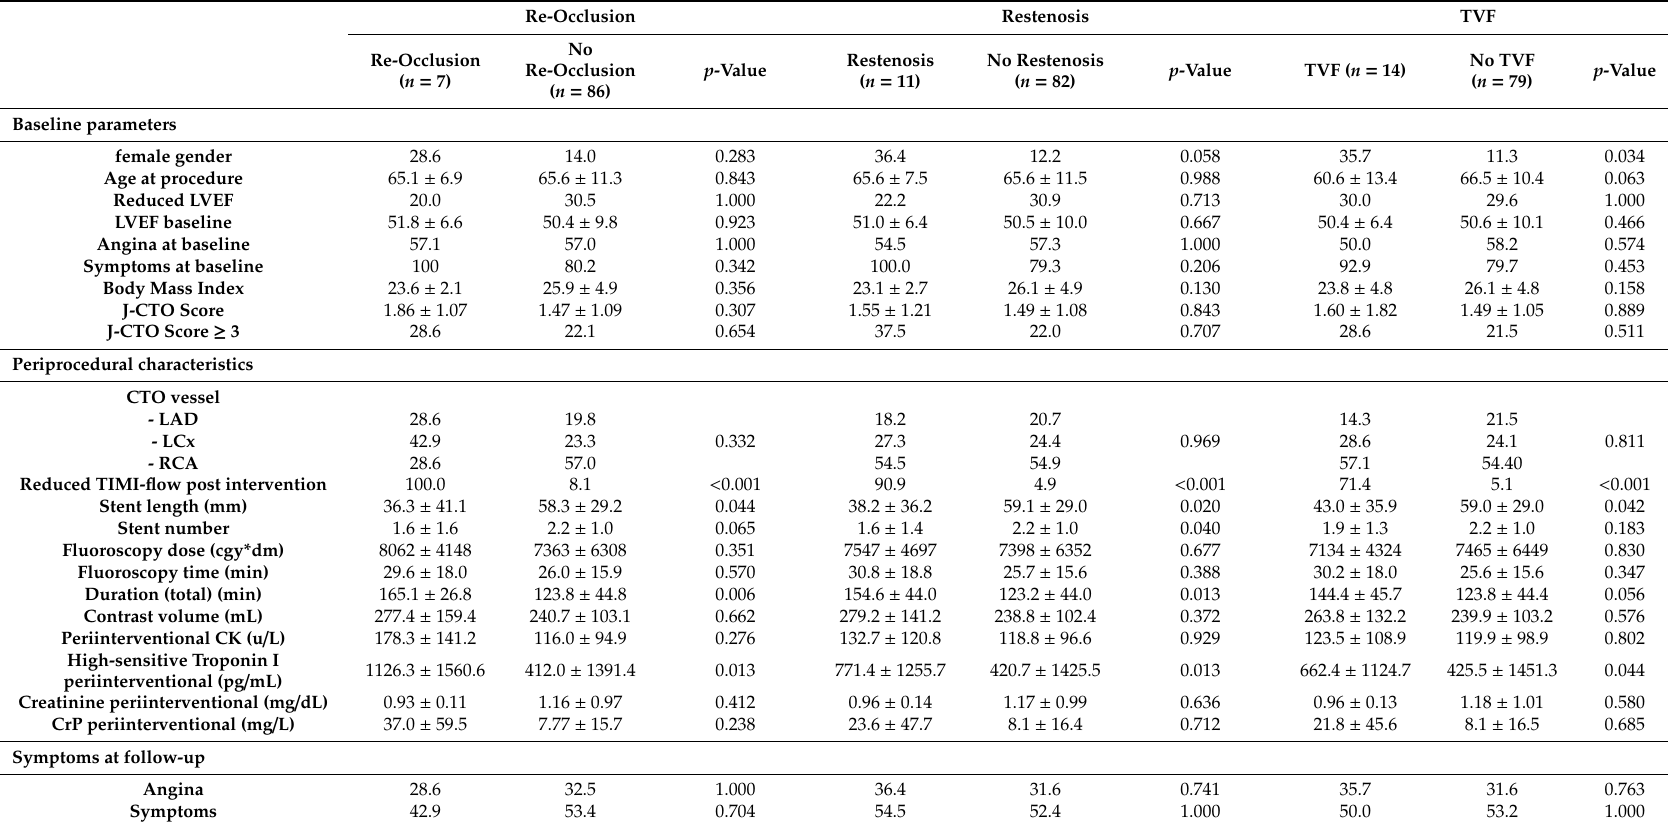
Table 2. Patients’ baseline, periprocedural, and follow-up characteristics stratified for